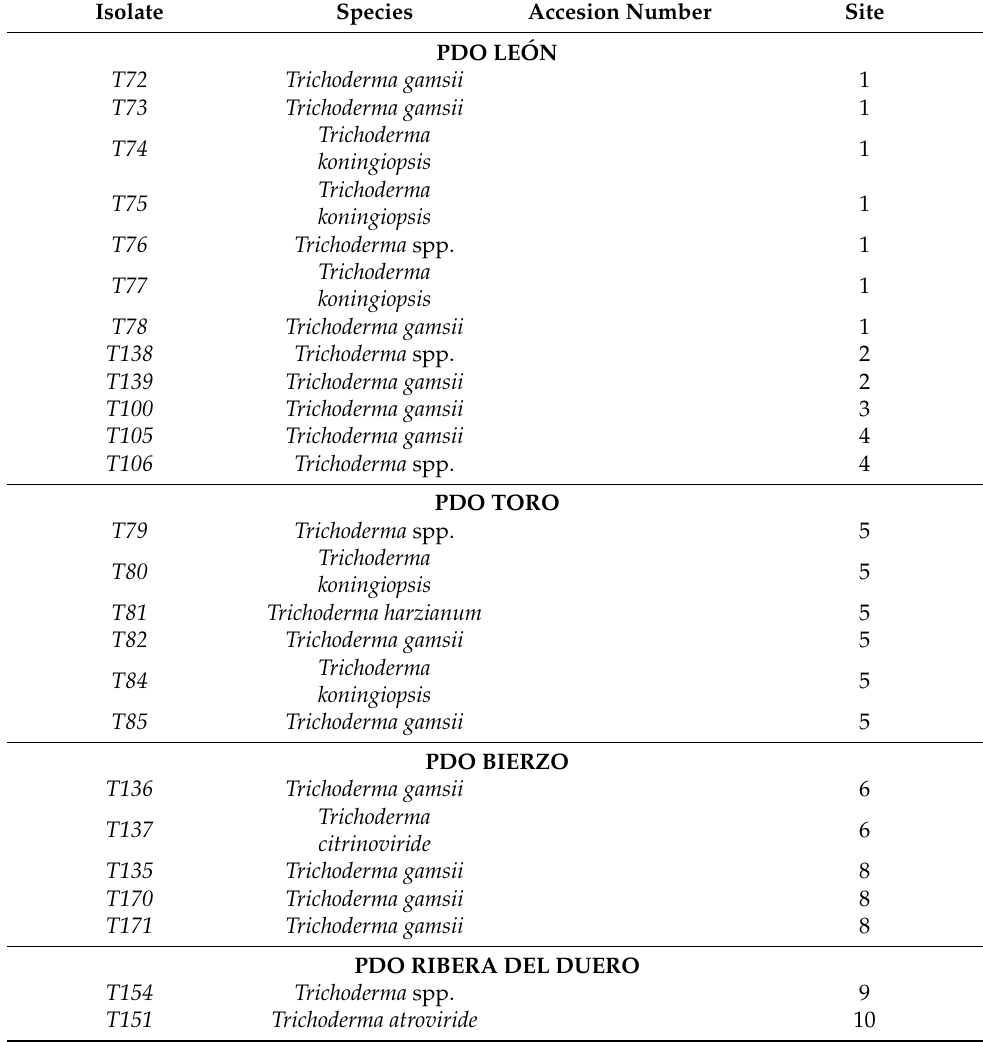
Table 3. Isolates of Trichoderma spp. in each